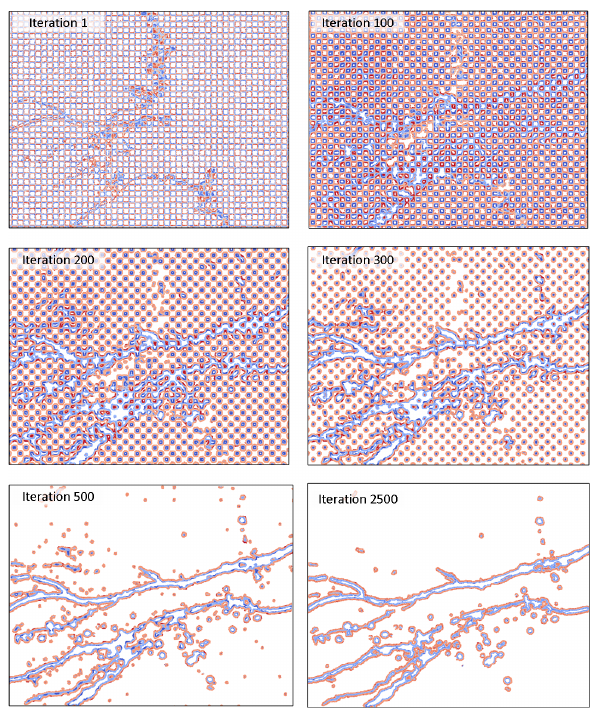
Figure 8. The development of the level-set function for the extraction of gullies and sinkholes with the voxel initialisation.